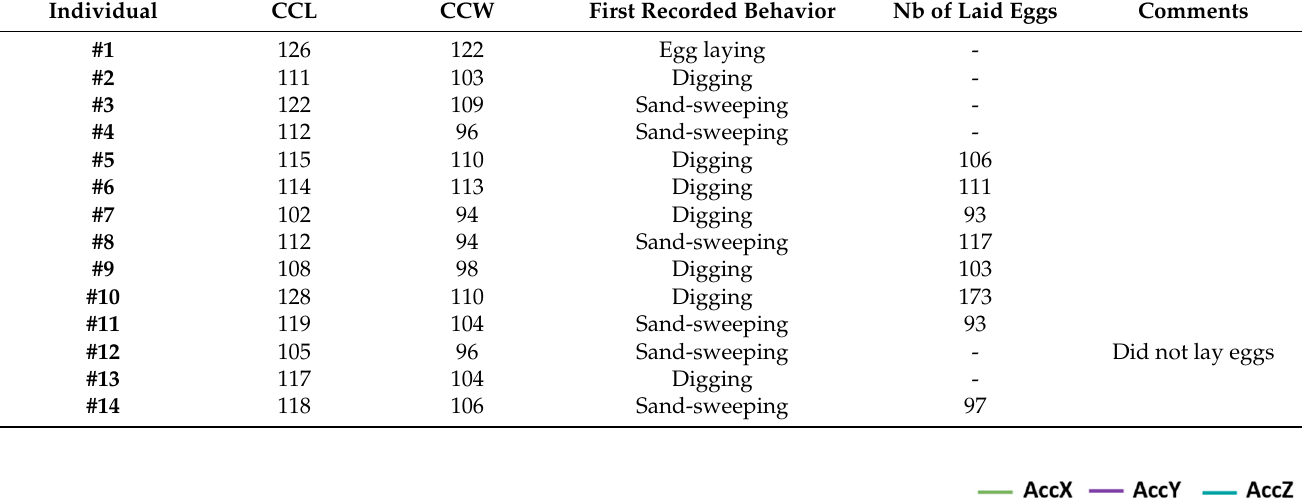
Table 1. Summary of the nesting green turtles’ measures and the observed number of laid eggs. CCL= Curved Carapace Length, CCW= Curved Carapace Width. The dashes indicate the individuals for which the number of laid eggs could not be counted.